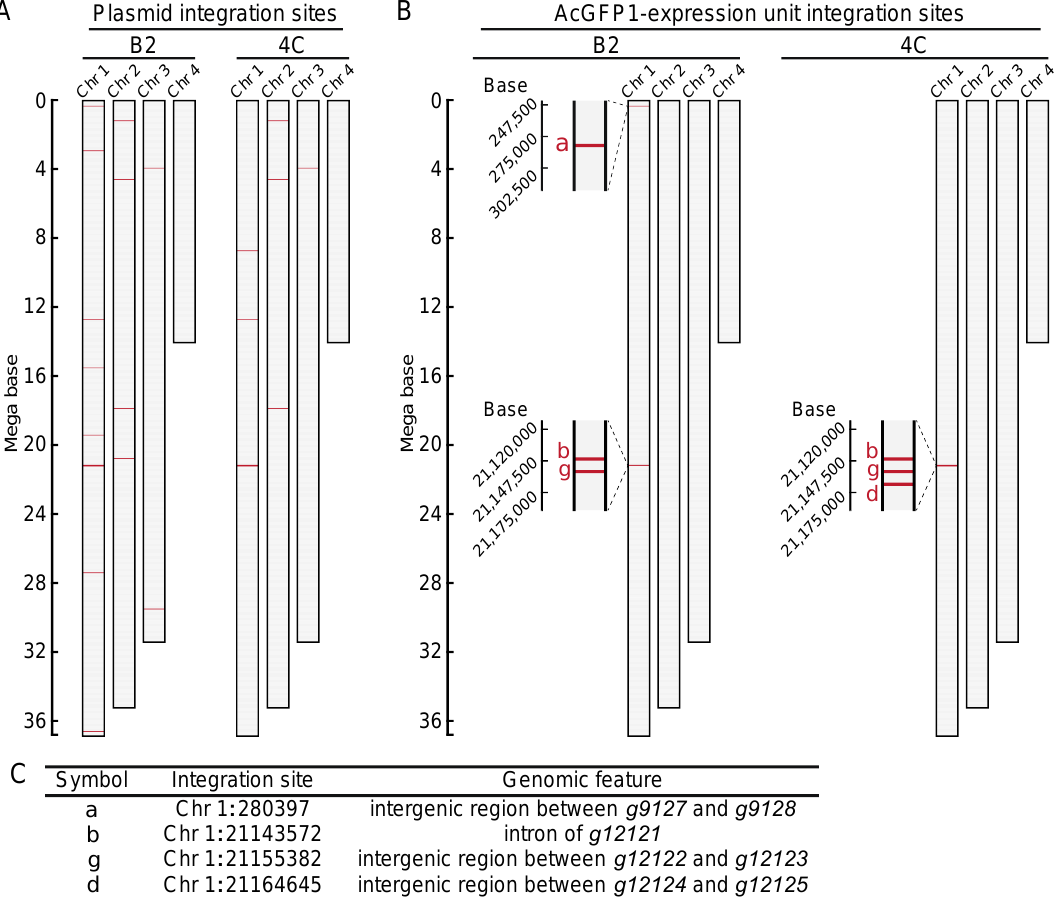
Figure 2. Genome-wide analysis of integration sites of the exogenous plasmid sequence in clonal cell lines, B2 and 4C. ( A ) Integration sites of the plasmid sequence are shown. ( B ) Integration sites of the AcGFP1-expression unit are shown. ( C ) Identified GSH candidates are listed, and their genomic features are described.